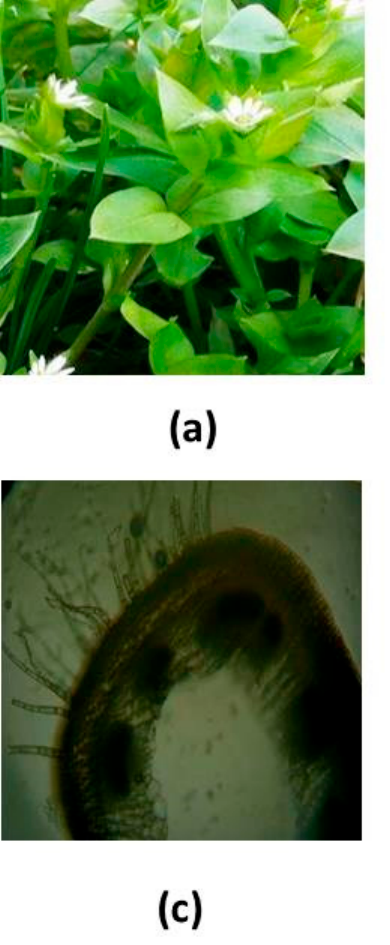
Figure 2. Macroscopic and microscopic characteristics of the plant Stellaria media (L.) Vill. ( a ) The aerial part of the plant Stellaria media (L.) Vill. Stelariae herba (personal photo), ( b ) flower of the plant Stellaria media (L.) Vill. (personal photo), ( c ) cross-section through the main stem (100 × ), ( d ) longitudinal section through the main stem (200 × ) .